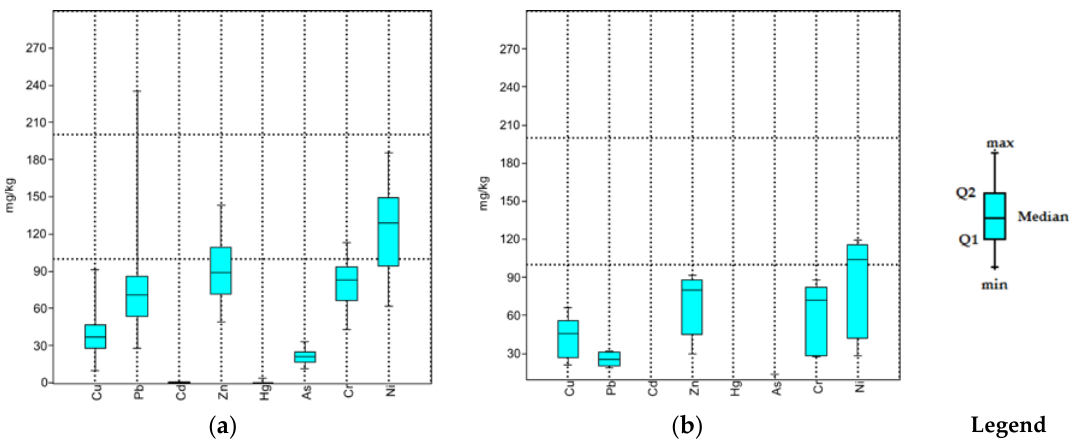
Figure 3. Graphical presentation of descriptive statistical parameters of analyzed concentrations of elements in Kostolac soil ( a ) and Gacko soil ( b ).